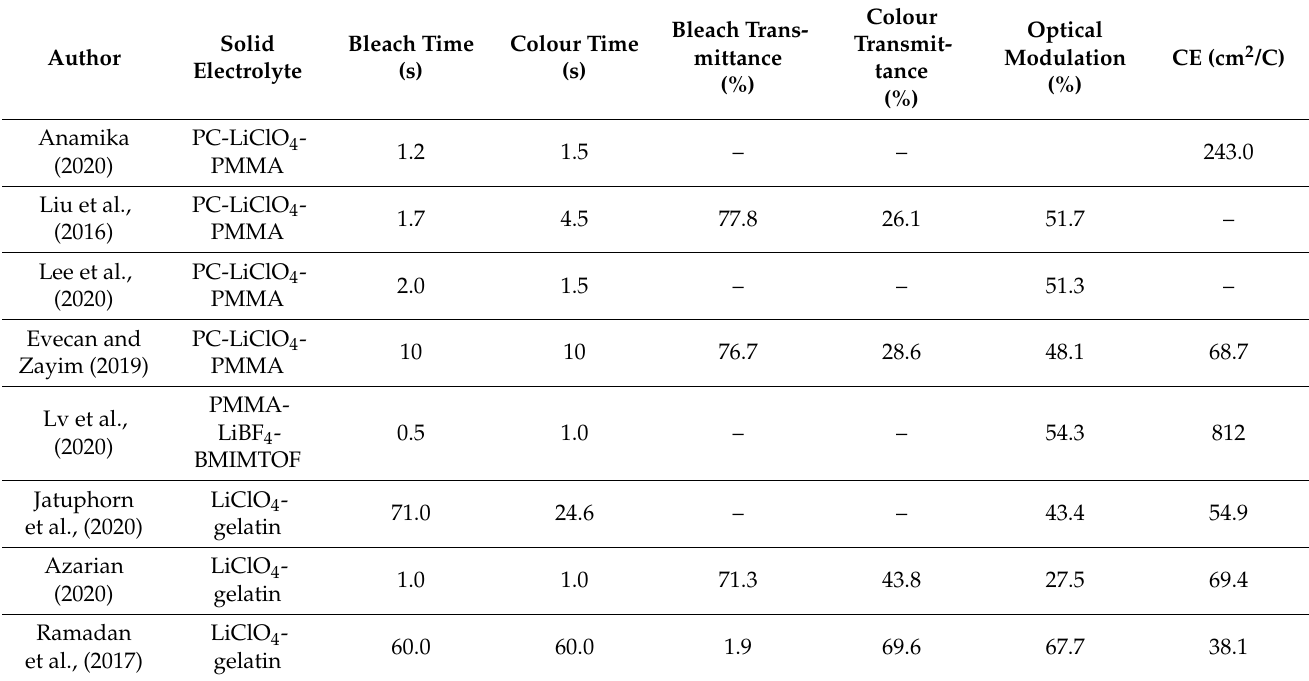
Table 2. Summary of ECD performance using various solid